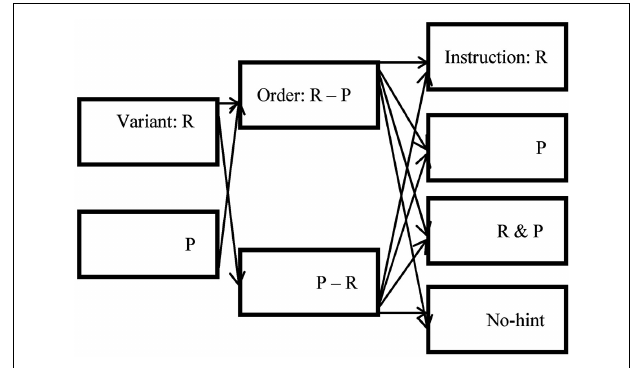
FIGURE 1 | Diagram showing variant type as a within-subjects factor (R = reward variant and P = punishment variant), order type